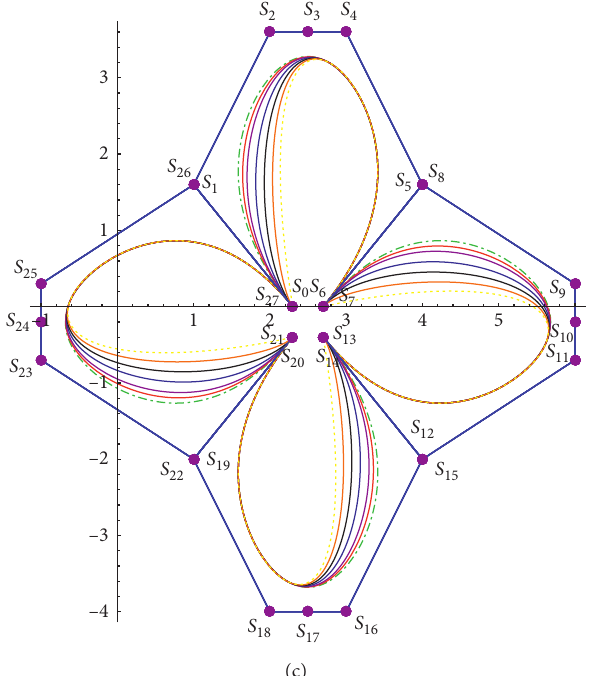
Figure 12: Construction of some open curves by different values of shape parameters. (a) μ � ω � 1 , 0 . 5 , 0 , − 1 , − 2 , − 3 , − 4. (b) μ � 1 , 0 . 5 , 0 , − 1 , − 2 , − 3 , − 4 , ω � 1. (c) ω � 1 , 0 . 5 , 0 , − 1 , − 2 , − 3 , − 4 , μ �